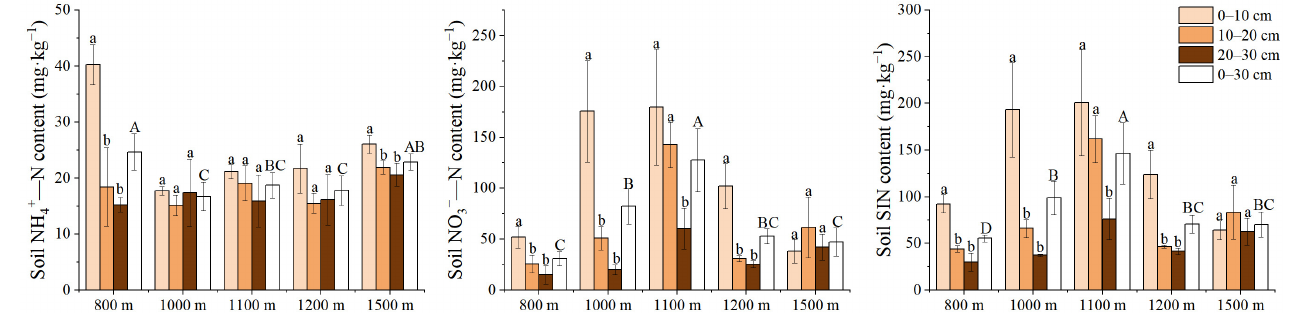
Figure 2. Variation characteristics of the soil’s NH 4+ —N, NO 3 − —N and SIN contents at different elevations. Different lowercase letters indicate significant differences between different soil layers at the same elevation gradient ( p < 0.05). Different capital letters indicate significant differences among the different elevation gradients ( p < 0.05).